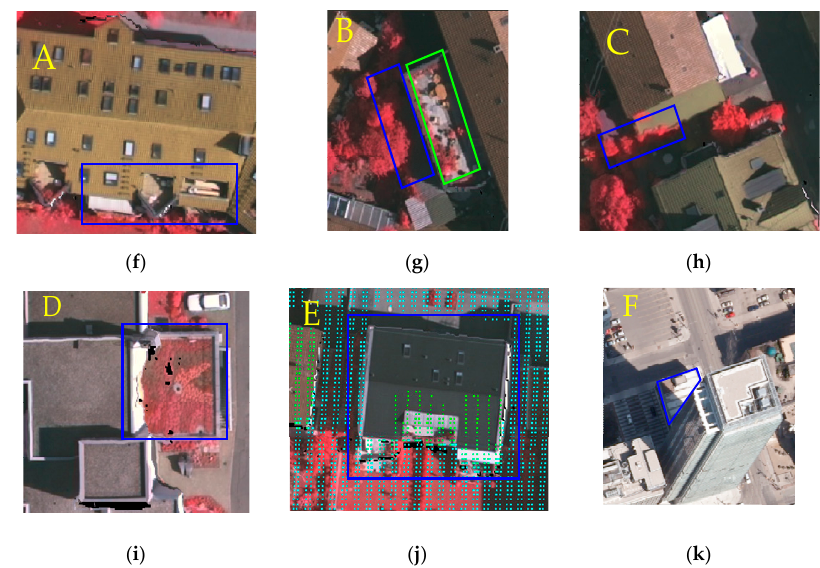
Figure 11. Visualization of building extraction results at the per-pixel level and error factors. ( a ) Area 1; ( b ) Area 2; ( c ) Area 3; ( d ) Area 4; ( e ) Area 5; ( f ) Details of A in Area 1; ( g ) Details of B in Area 1; ( h ) Details of C in Area 1; ( i ) Details of D in Area 2; ( j ) Details of E in Area 3; ( k ) Details of F in Area 4.